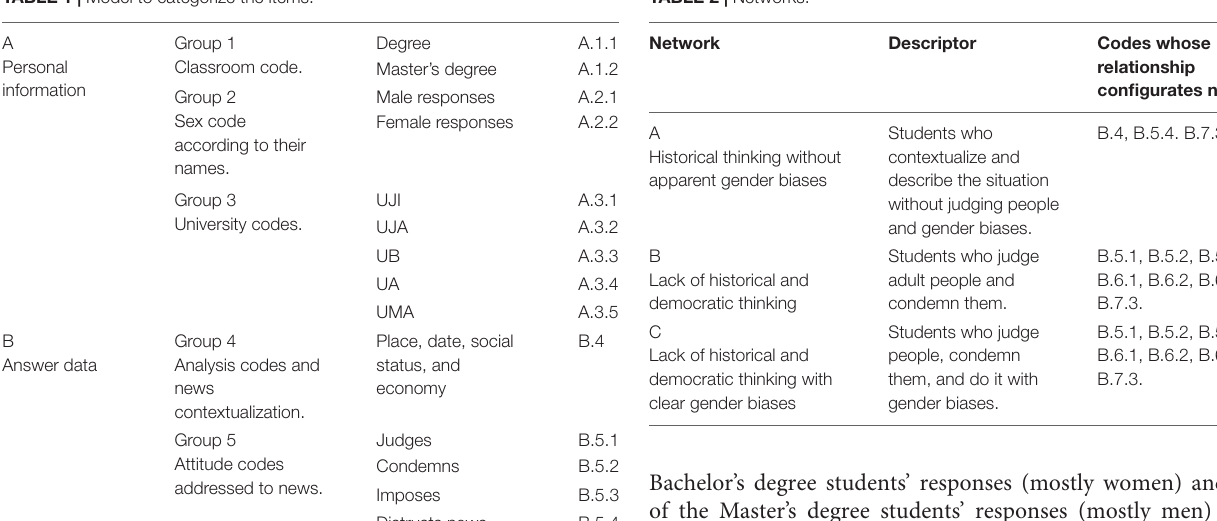
TABLE 1 | Model to categorize the